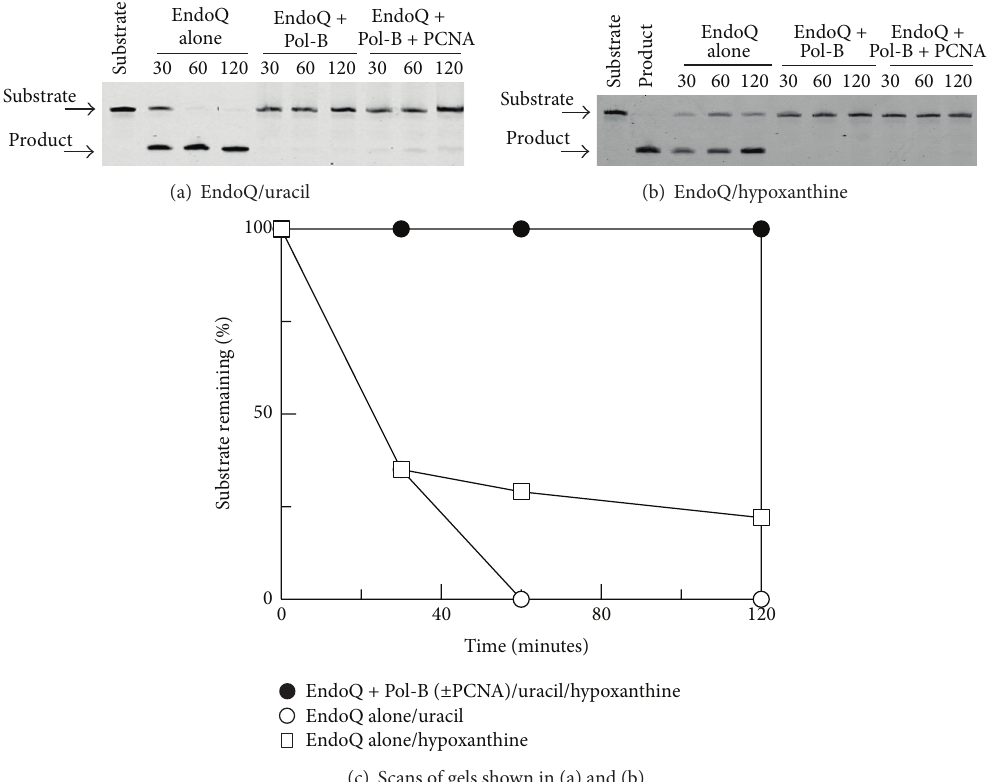
Figure 1: Influence of DNA polymerase-B on the activity of EndoQ. (a) Denaturing gel showing inhibition of EndoQ by Pol-B and Pol-B plus PCNA with uracil. (b) Denaturing gel showing inhibition of EndoQ by Pol-B and Pol-B plus PCNA with hypoxanthine. The numbers above the gel lane indicate the hydrolysis time in minutes. (c) Scans of the gels shown in (a) and (b) indicating the amount of substrate remaining with time. In these experiments Pol-B exo − (D215A) was used. All experiments were repeated at least four times and the inhibition patterns observed were highly reproducible. The data points shown in the scans have an error of <±